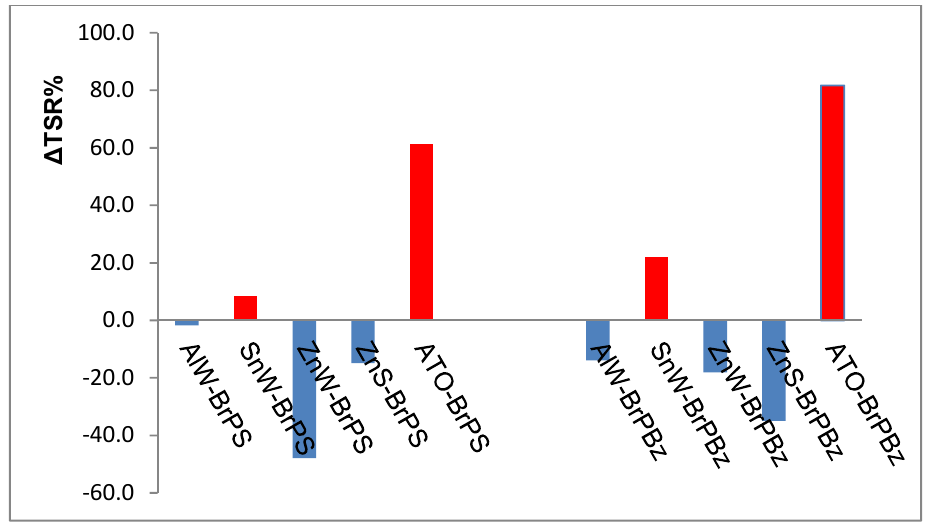
Figure 4. Percentage changes in smoke generation where the percentage change in total smoke release, Δ TSR% = [TSR (MC/PolyBrFR) /TSR (PolyBrFR) − 1] × 100 and TSR (MC/PolyBrFR) and TSR (PolyBrFR are the respective smoke release values for each metal compound (MC) in combination with each PolyBrFR and PolyBrFR alone in PA66: Red columns indicate an increase and blue columns a decrease in smoke generation with respect to that from either brominated polystyrene, BrPS, or poly(pentabromobenzyl acrylate), BrPBz, present in PA66 alone. AlW, SnW and ZnW = aluminium, tin (II) and zinc tungstates respectively; ATO = antimony (III) oxide and ZnS = zinc stannate.